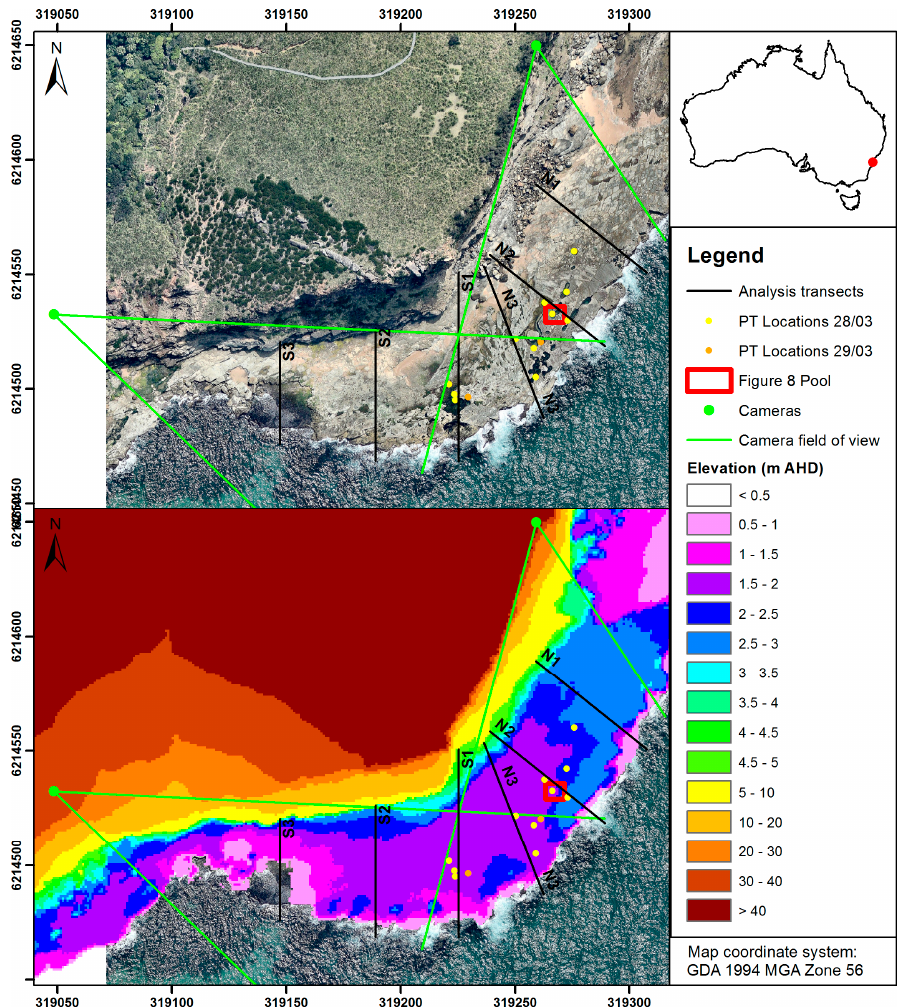
Figure 2. Site map of the Figure Eight Pools Rock Platform showing the camera locations and fields of view, locations of pressure transducers, the timestack transect lines, and the location of the Figure Eight Pool. The upper panel shows an aerial image (Source: NearMap) of the site captured on 10 October 2016 and the lower panel shows LiDAR elevation data relative to the Australian Height Datum (AHD). The inset in the upper right corner shows the location of the site within Australia.